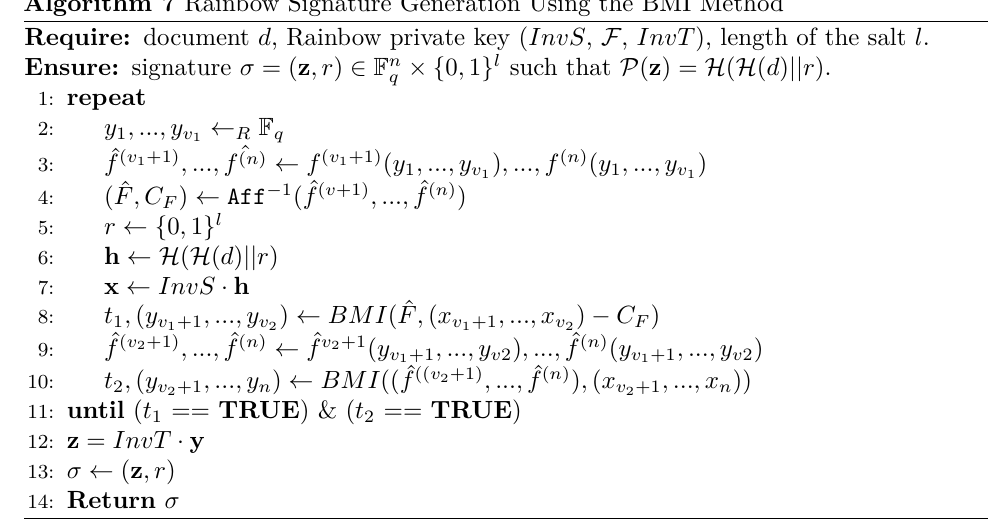
Algorithm 7 Rainbow Signature Generation Using the BMI Method